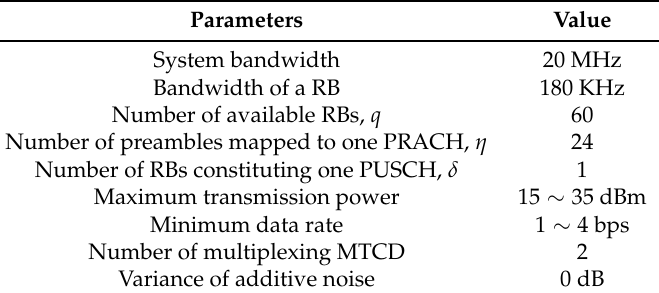
Table 1. Simulation Parameters.